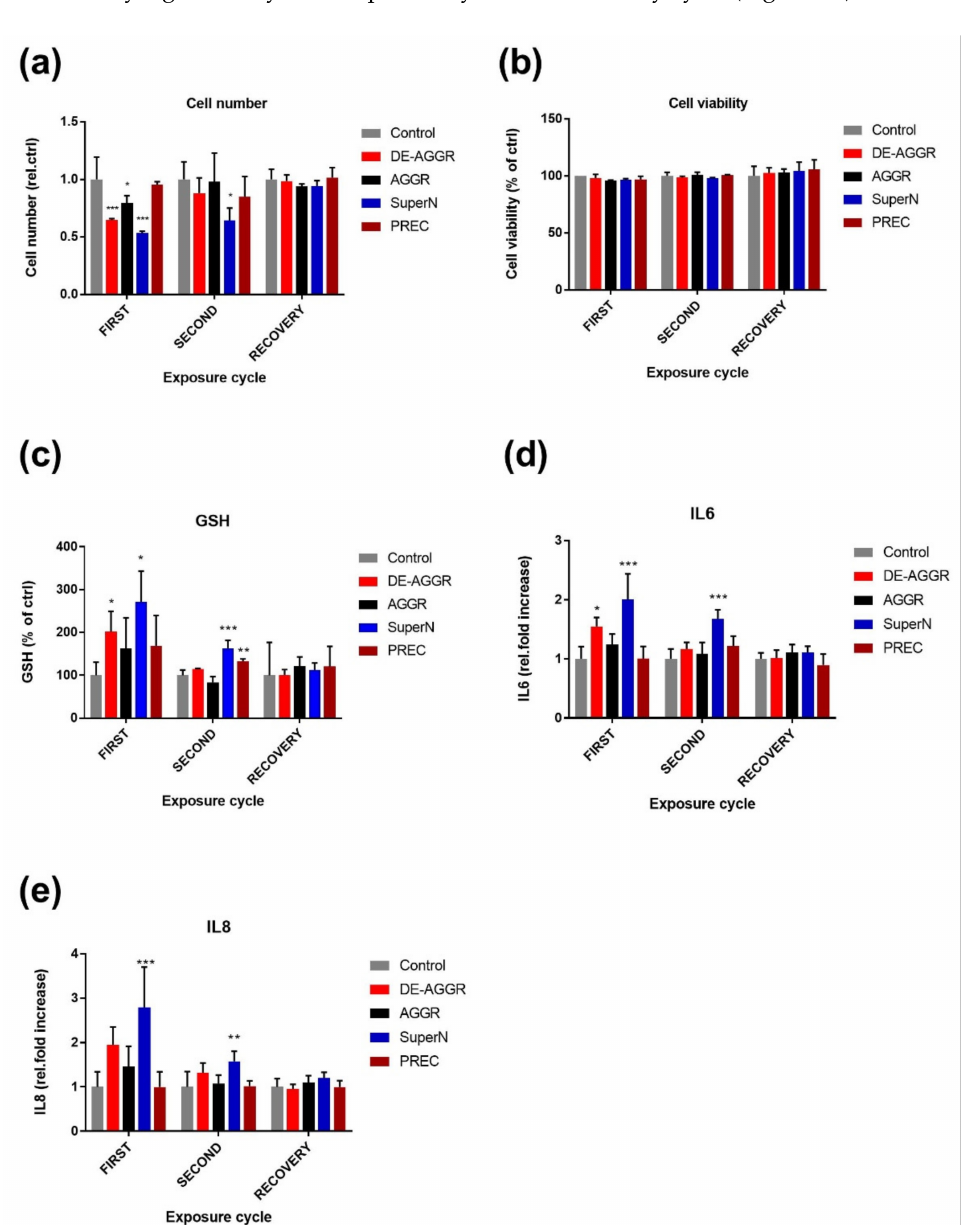
Figure 4. Effect of repeated exposure to different SAS suspensions (0.76 µ /cm 2 ) on biological responses. Cell proliferation ( a ), cell viability ( b ), total glutathione levels (GSH) ( c ), IL6 ( d ), and IL8 ( e ) were measured in HBE cell cultures after different exposure cycles. Recovery denotes a week of exposure to cell culture medium without SAS. Data are expressed as means ± SD from two independent experiments performed in duplicate. p < 0.05 (*), p < 0.01 (**) and p < 0.001 (***) represent significant differences compared to control (One-way ANOVA followed by Dunnett’s multiple comparison test). DE-AGGR—de-aggregated suspension; AGGR—aggregated suspension; SuperN—non-precipitating suspension; PREC—precipitating